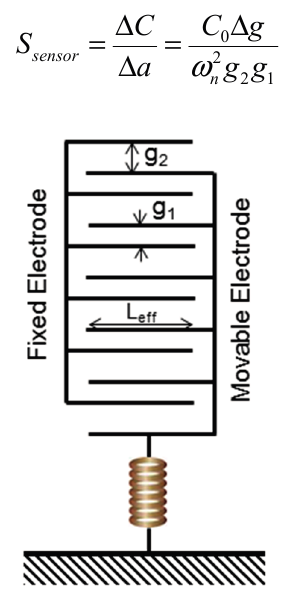
Figure 2. Inter-digitized comb fingers with asymmetric